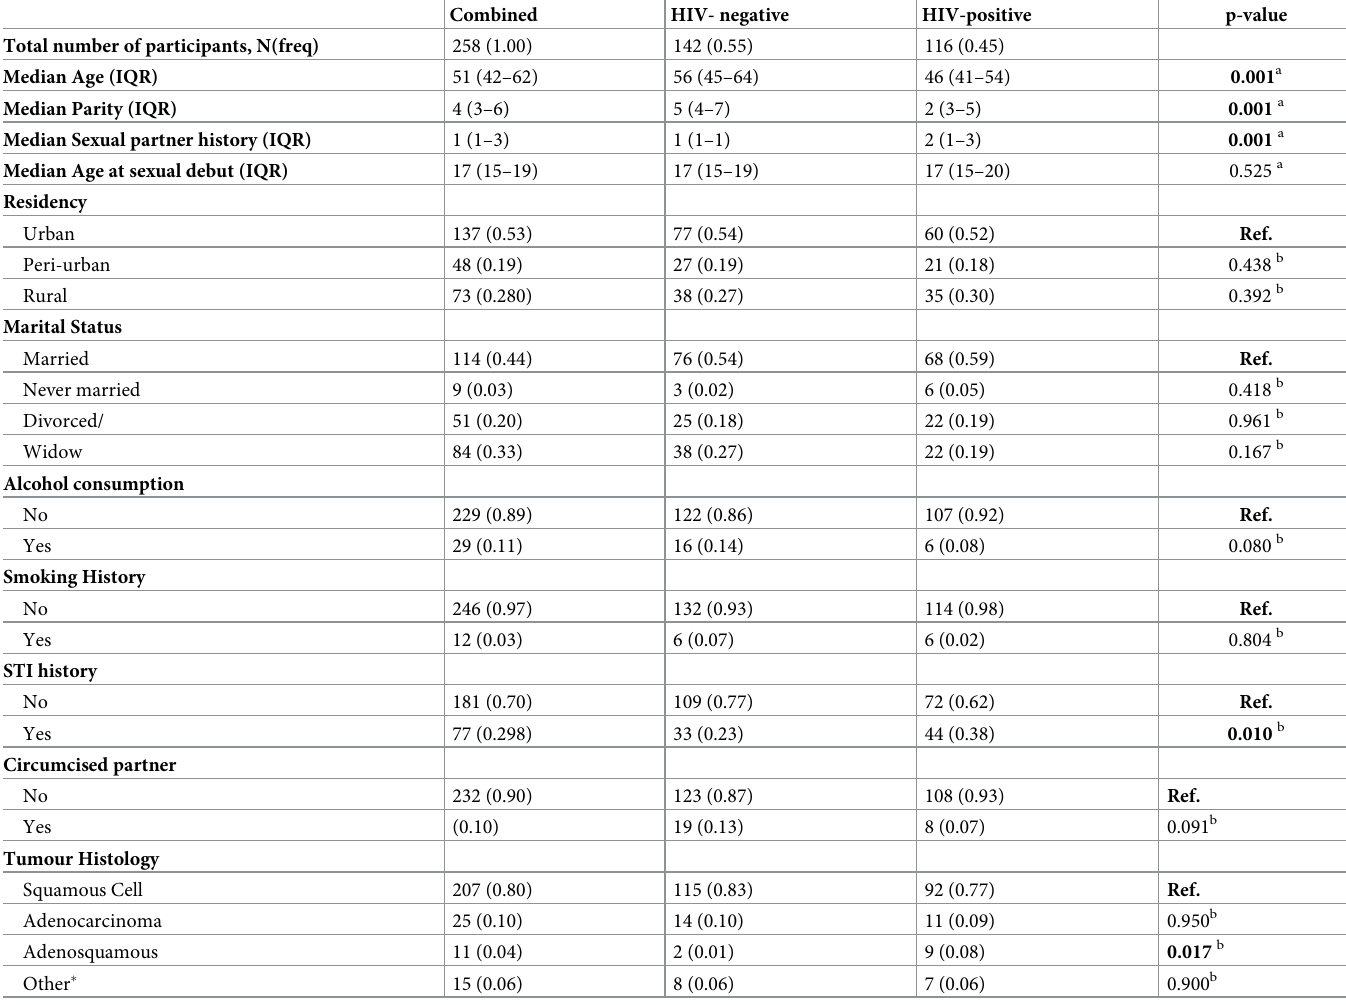
Table 1. Sociodemographic and behavioural characteristics of the study